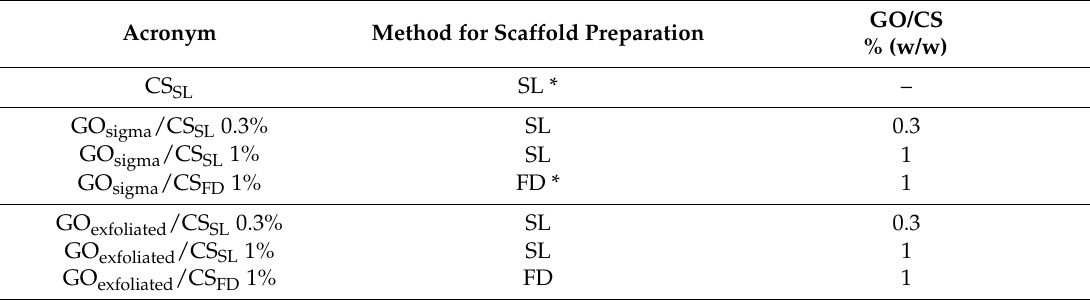
Table 4. Types of prepared scaffolds and corresponding acronyms.